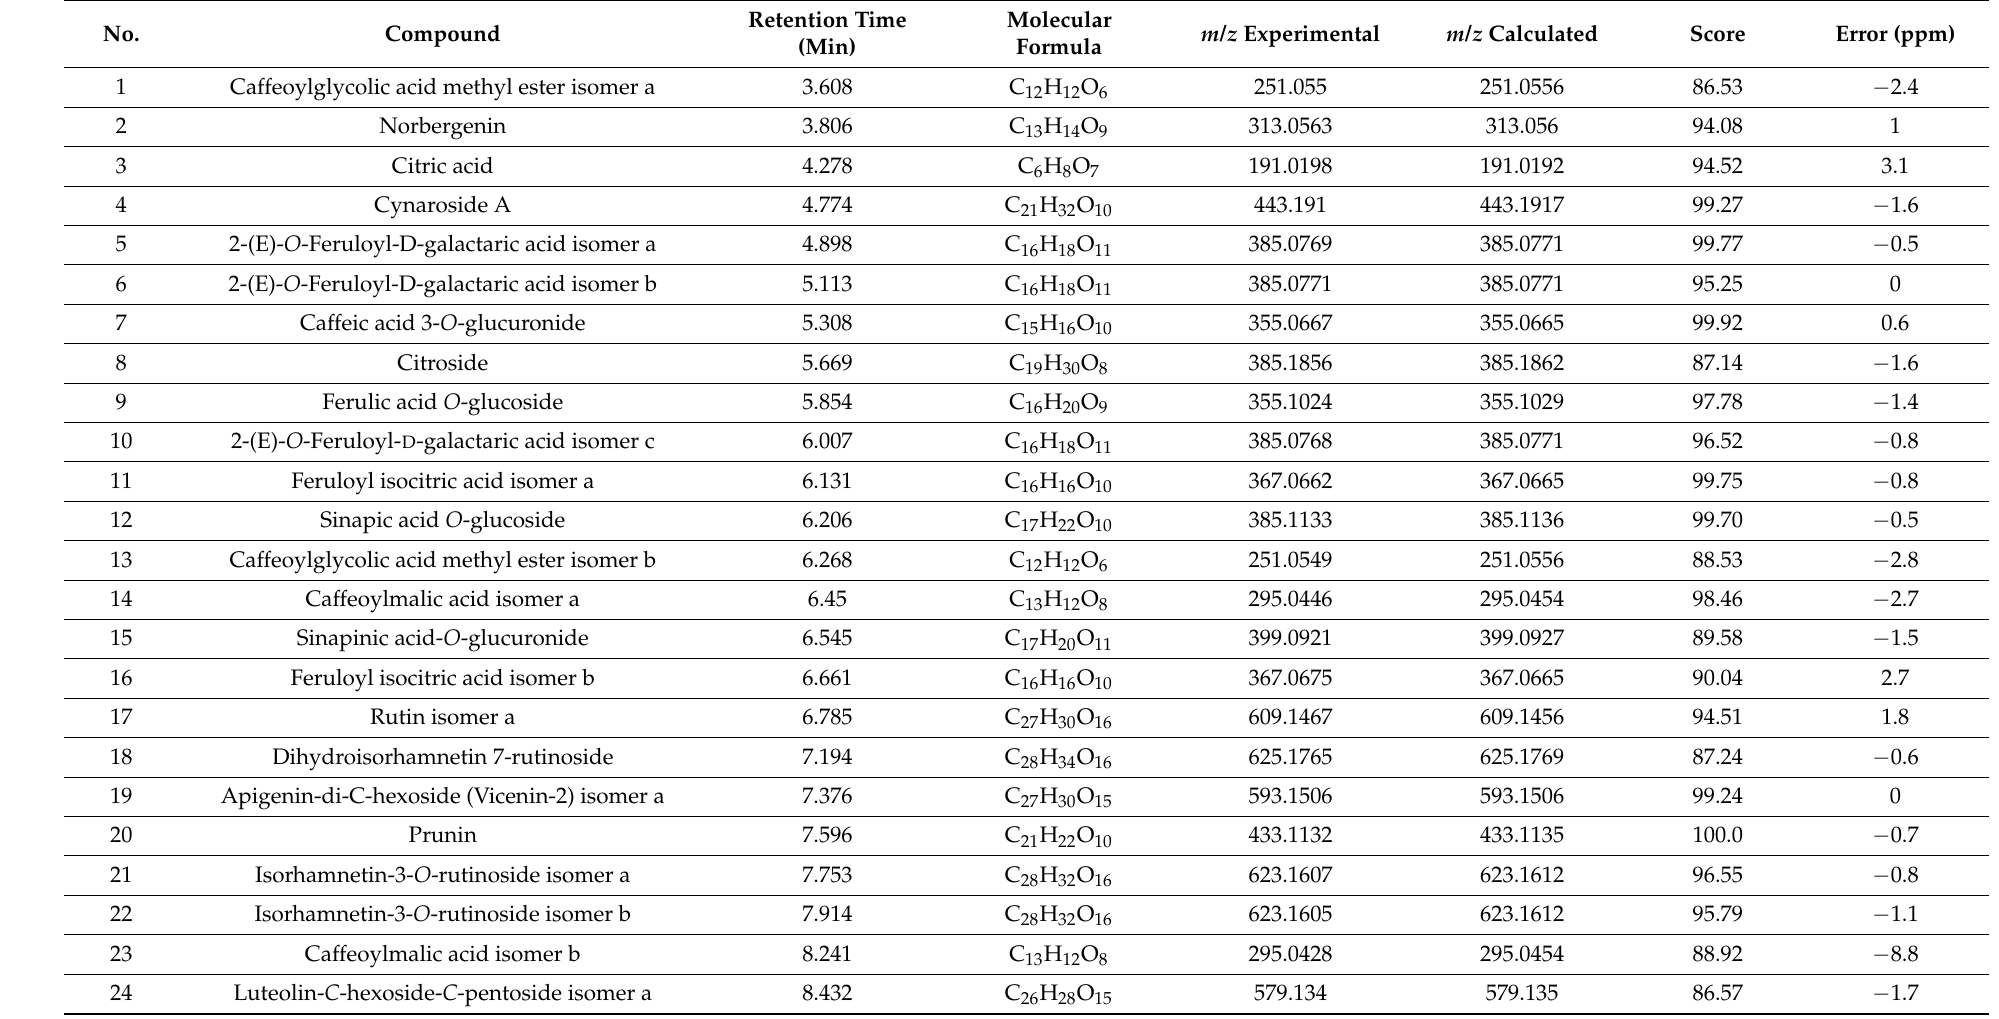
Table 6. Compounds identified by HPLC-ESI-TOF-MS in the optimal extract of orange